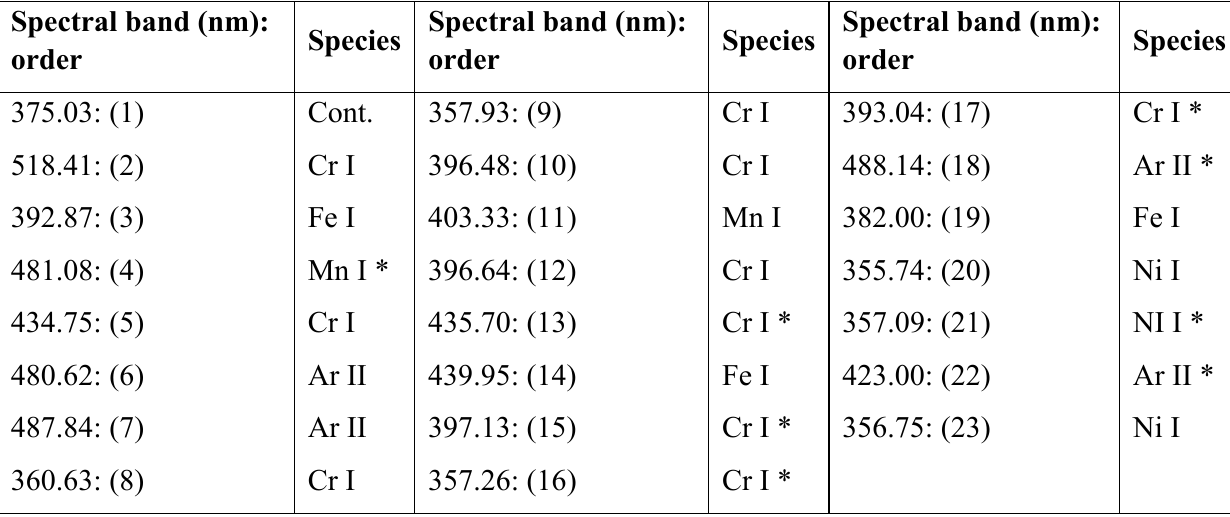
Table 1. Spectral bands selected and listed by SFFS and related to species participating in the plasma: experimental